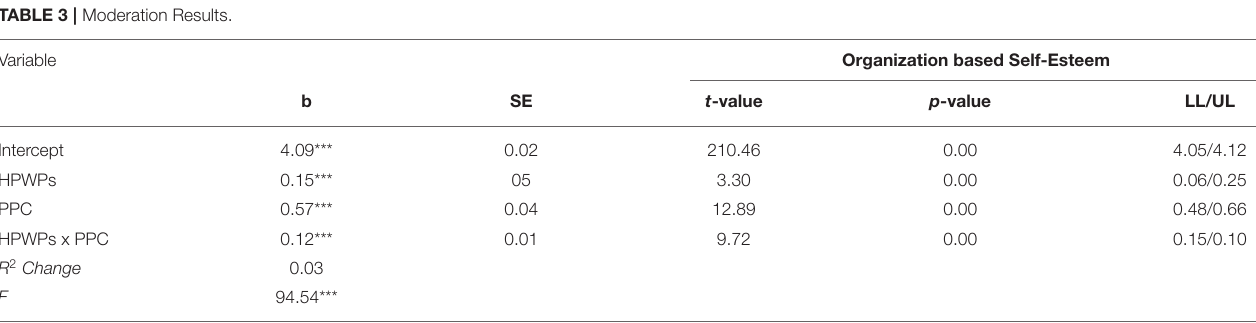
TABLE 3 | Moderation Results.